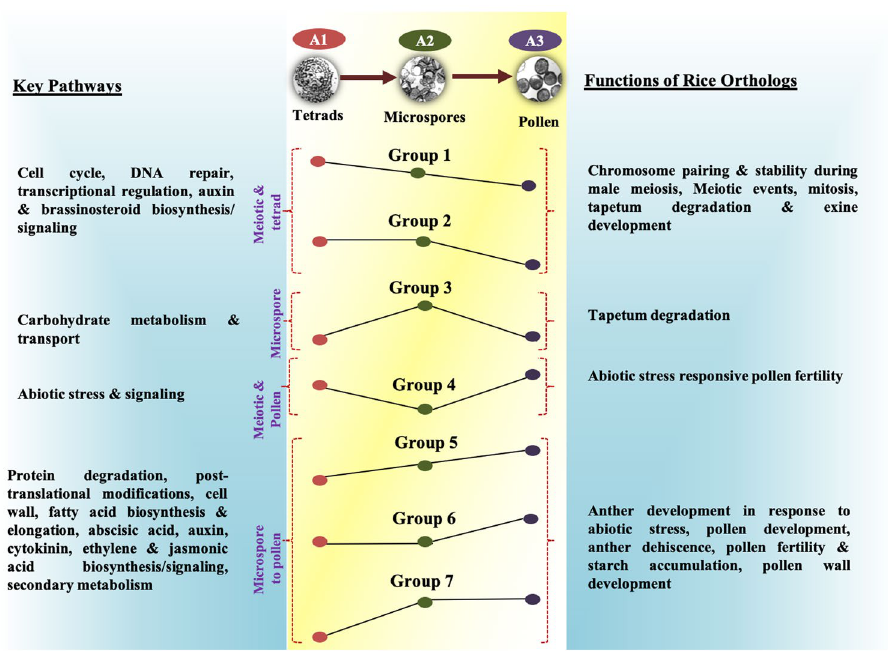
Figure 6. Overview of dominant patterns and associated functions. Four different types of patterns representing premeiotic to tetrad stage preferential expression, microspore-preferential, early and late pollen- preferential and mature pollen preferential patterns are shown in the middle. The key pathways associated with each category are shown on the left, while right panel indicating key functions exhibited by rice orthologs of sorghum genes identified in these